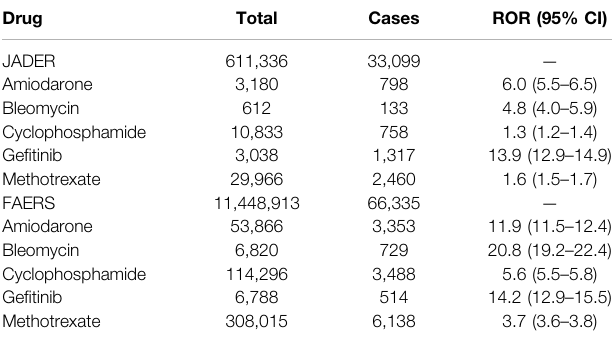
TABLE 1 | Major interstitial lung disease-inducing drugs.